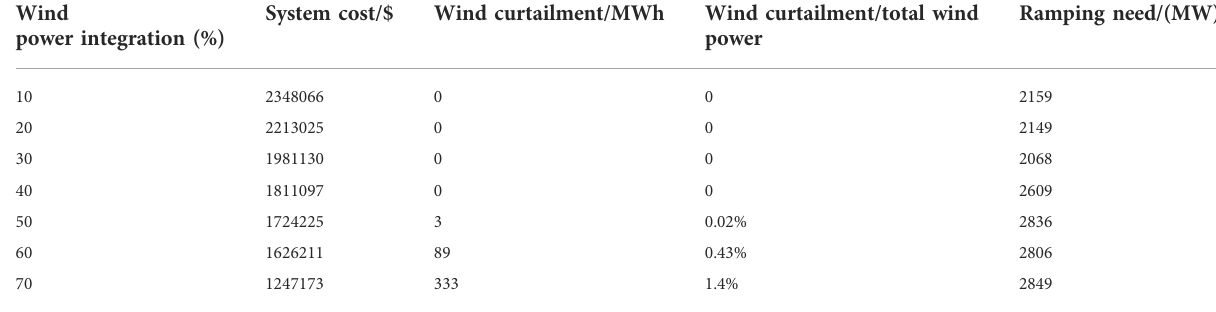
TABLE 5 Effects of different wind power integrations. Wind power integration (%)